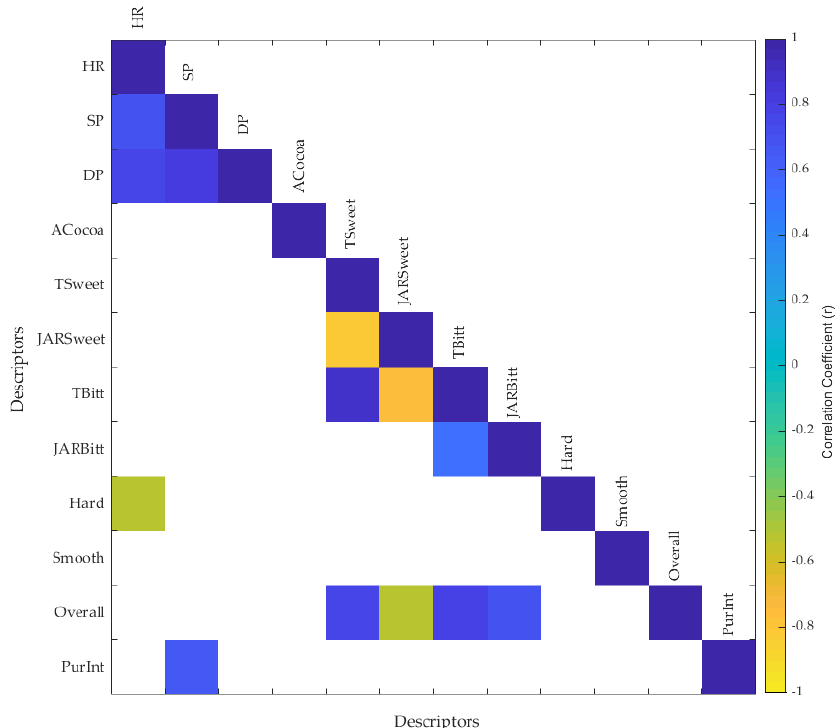
Figure 9. Correlation matrix of a chocolate sensory test showing the significant correlations ( p < 0.05) in which the blue side of the color scale (−1 to 1) represent the positive and the yellow side the negative correlations. Abbreviations: (i) heart rate (HR), (ii) systolic pressure (SD), (iii) diastolic pressure (DP), (iv) liking of cocoa aroma (ACocoa), (v) liking of sweetness (Tsweet), (vi) sweetness intensity with just about right (JAR) test (JARSweet), (vii) liking of bitterness (TBitt), (viii) JAR of bitterness intensity, (ix) liking of hardness (Hard), (x) liking of smoothness (Smooth), (xi) overall liking, and (xi) purchase intention